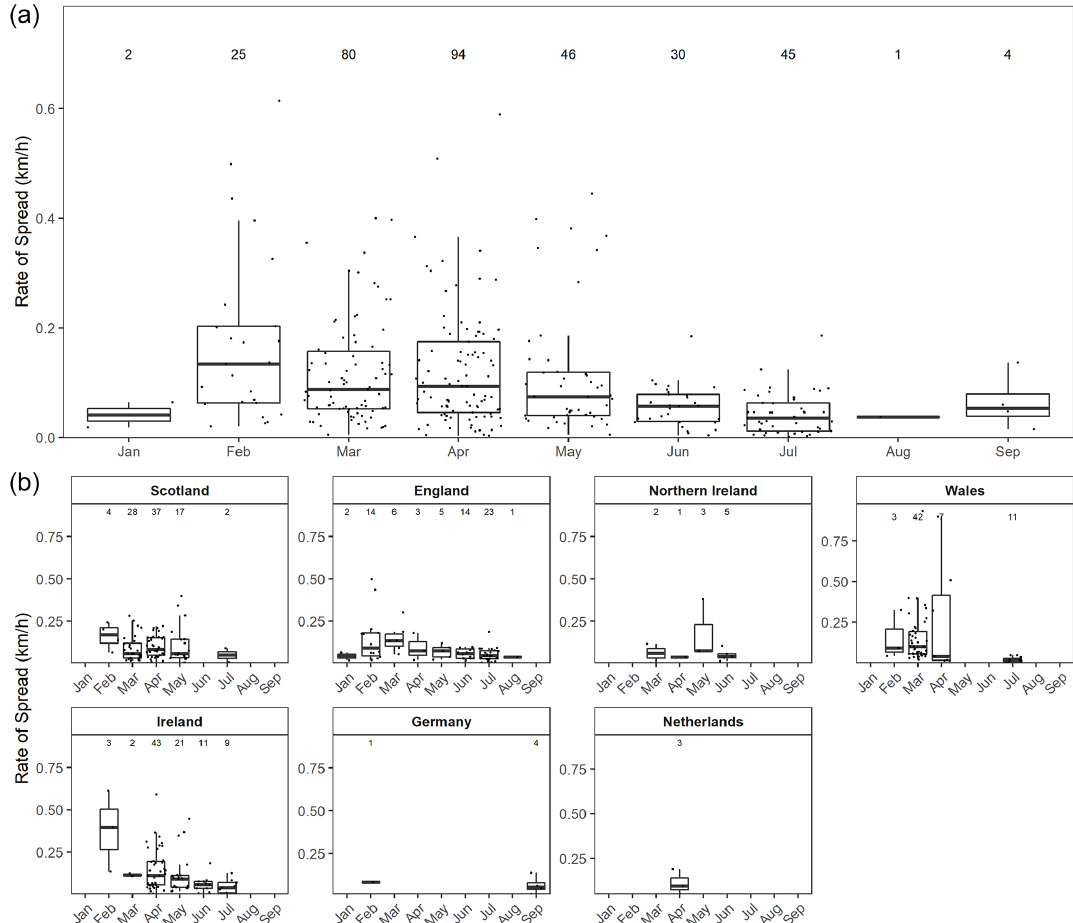
Figure 4. Rate of spread for northwest Europe from 2012–2020 calculated monthly (a) for the northwest European area (northern Atlantic biogeographical region) and (b) per country. Points represent sample size, which is also indicated as numbers on top of each boxplot. Fires were not detected for months not represented in the